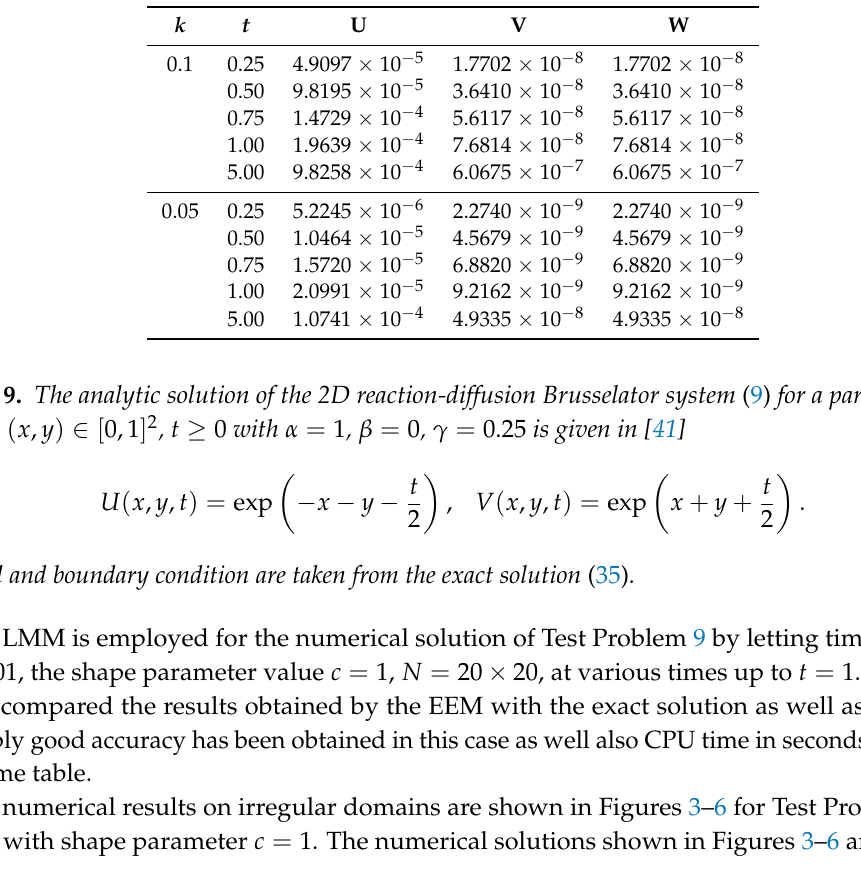
Table 10. Numerical results of the EEM in form of L ∞ error norm for Test Problem